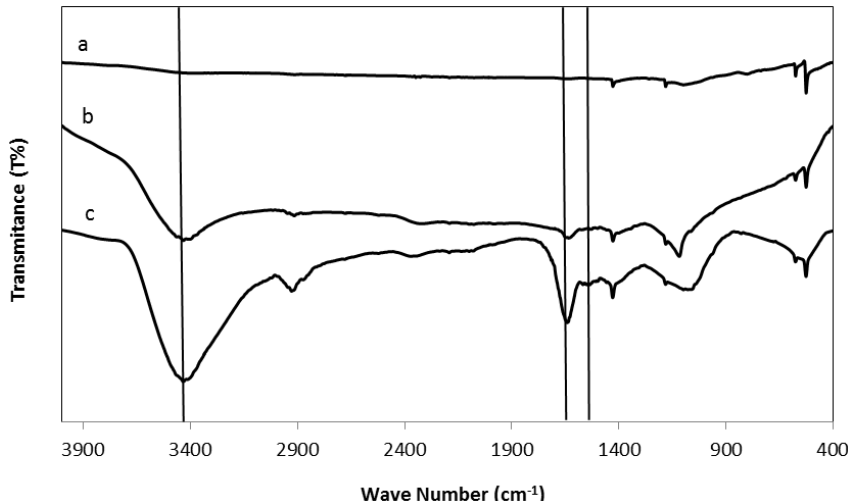
-COOH ( b ), and C 60